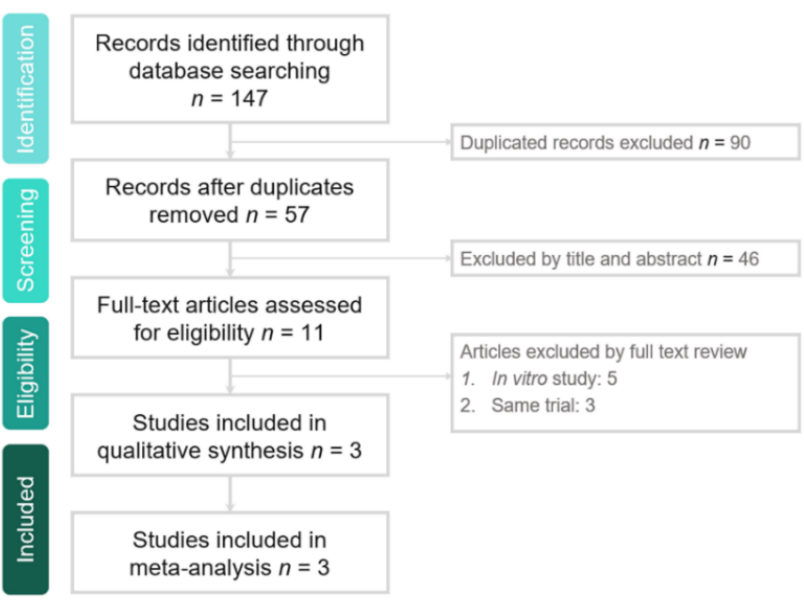
Figure 1. Study selection process flow.